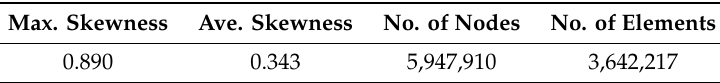
Table 2. Statistics and quality of the generated mesh.